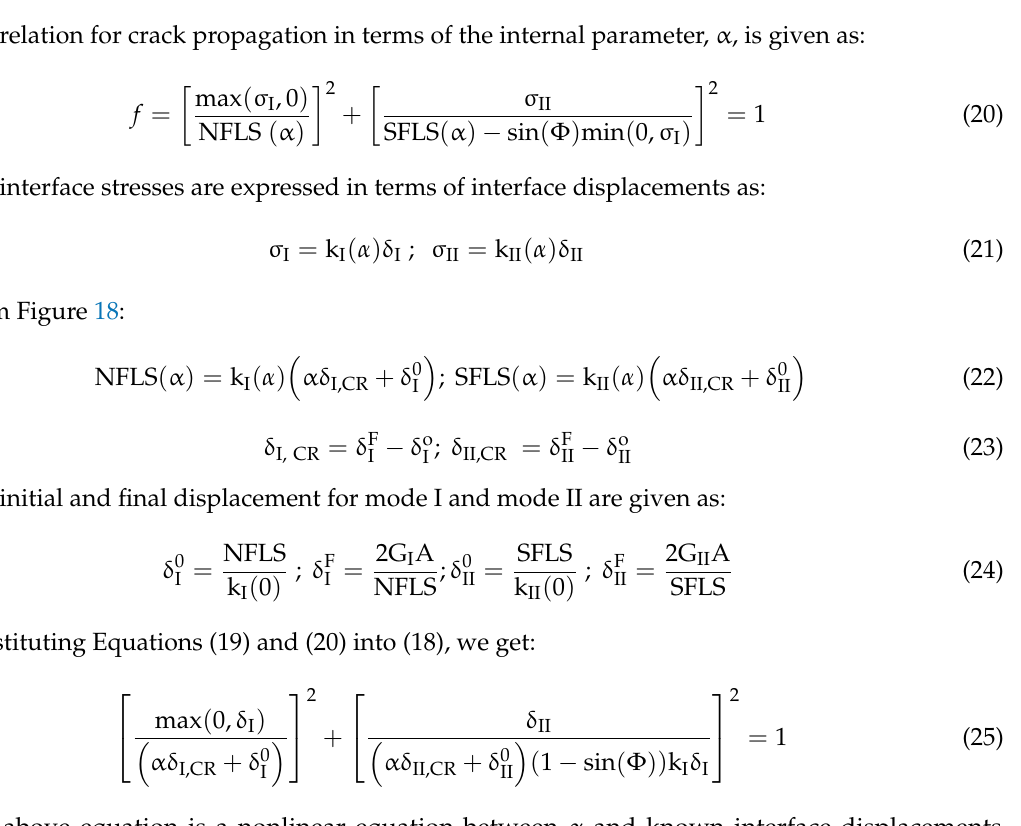
Figure 17. Iso-lines of internal parameter α [56].